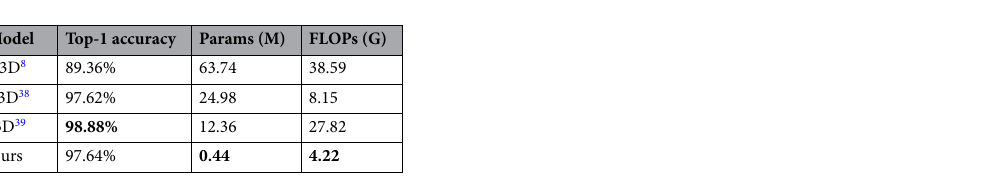
Table 5. The performance of gesture recognition on the Northwestern University datasets. Significant values are in bold.